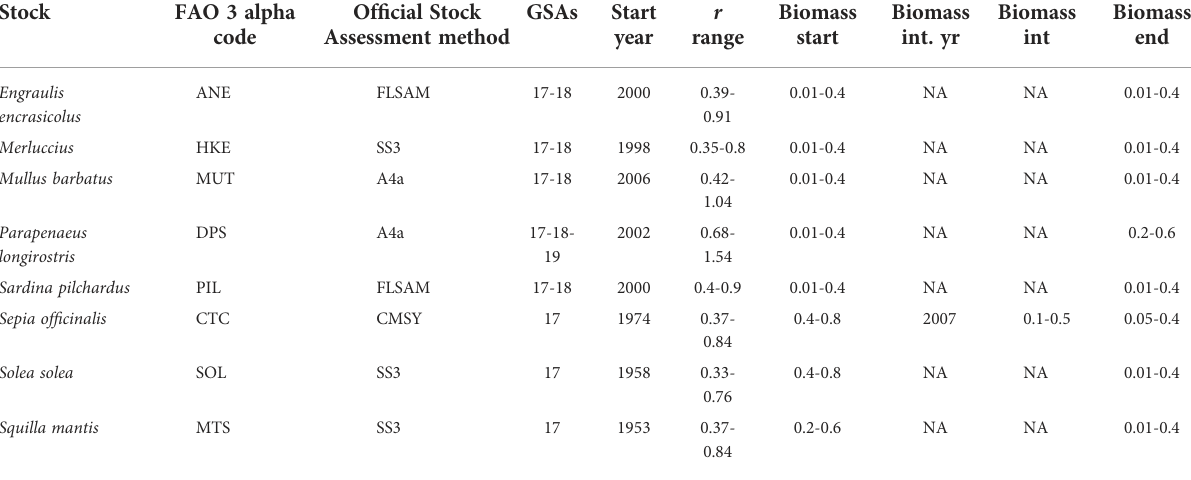
TABLE 1 Summary of the stocks analysed in the present paper, with references to the FAO 3 alpha code, the assessment method used in the of fi cial context, the geographical aggregation (GSAs), and data and priors used in the CMSY analysis.